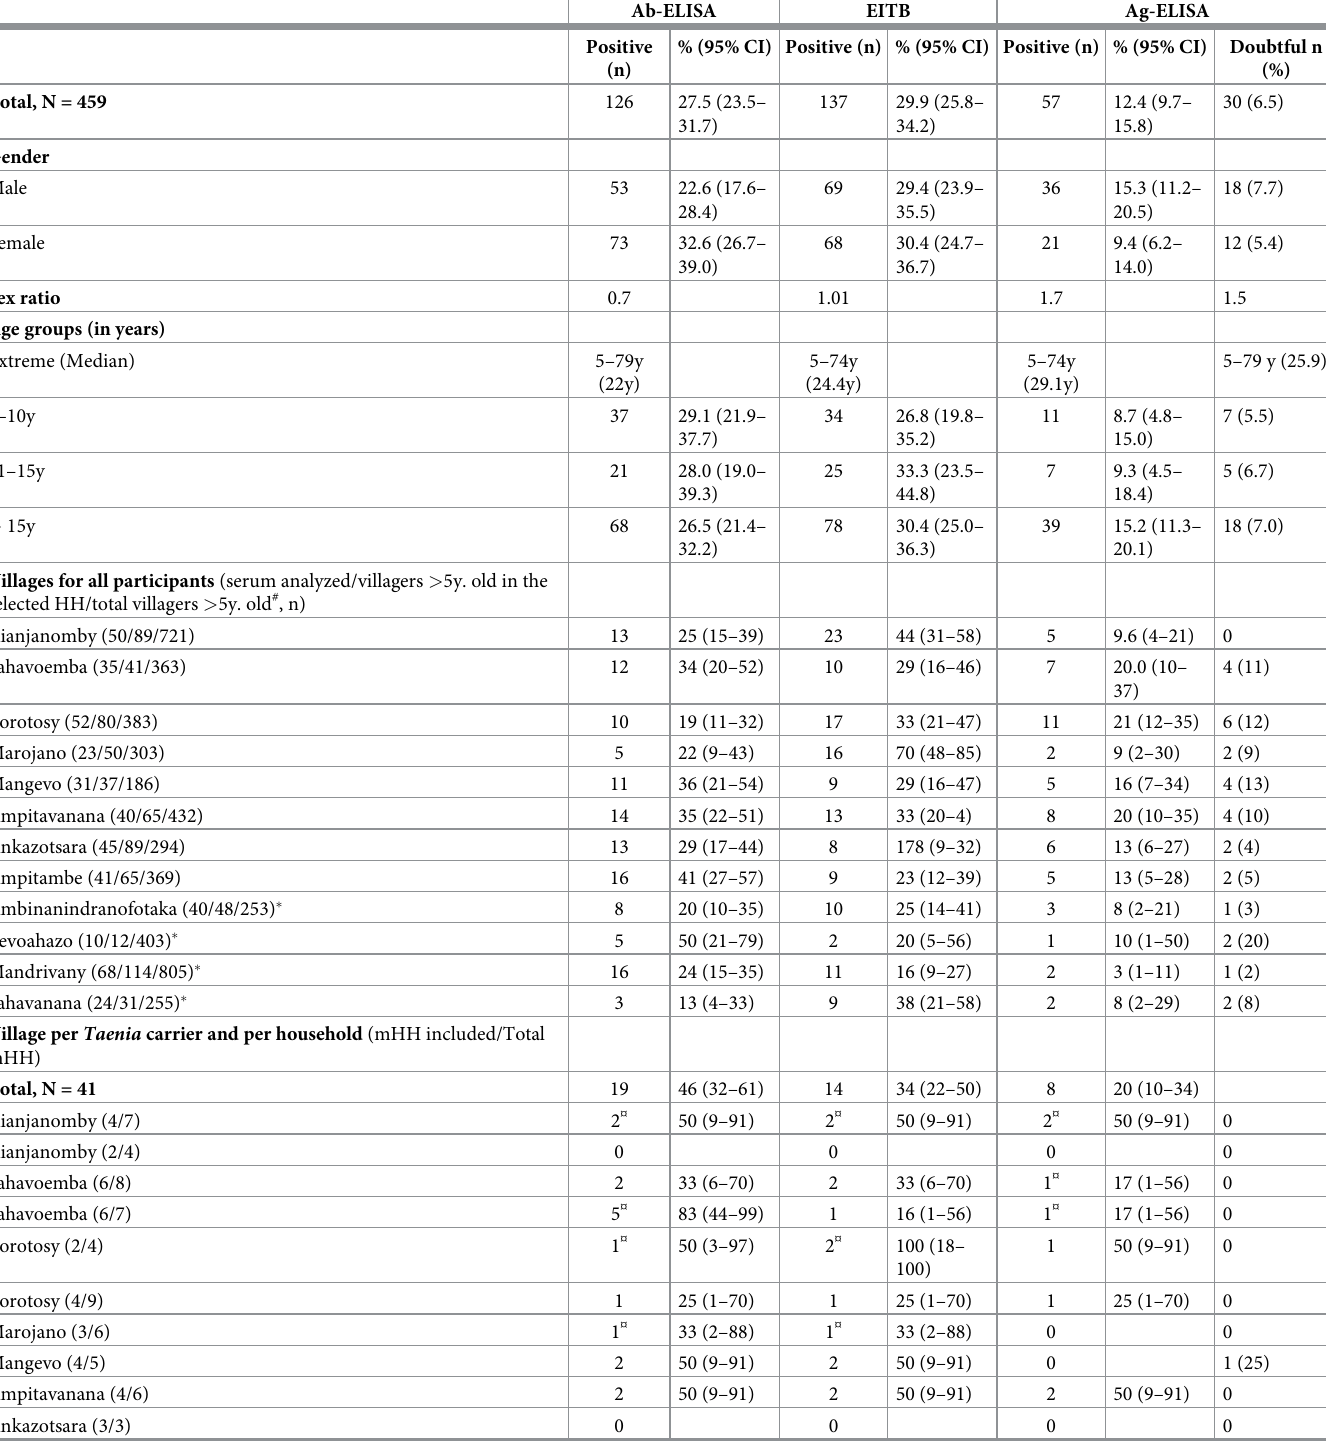
Table 3. Seroprevalence of T . solium anti-cysticercal antibodies (Ab-ELISA and EITB assays, IgG) and cysticercal Antigens (Ag-ELISA) for all participants investi- gated and within the Taenia carrier